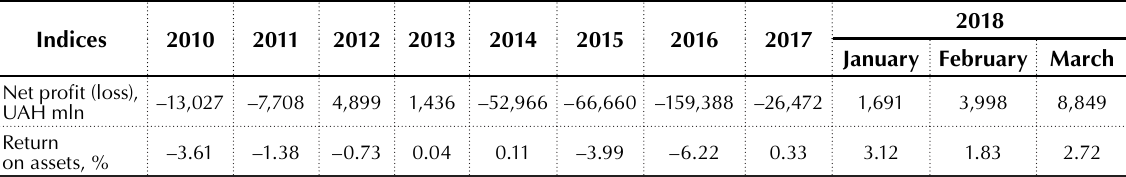
Table 2 indicates that the banking sector received